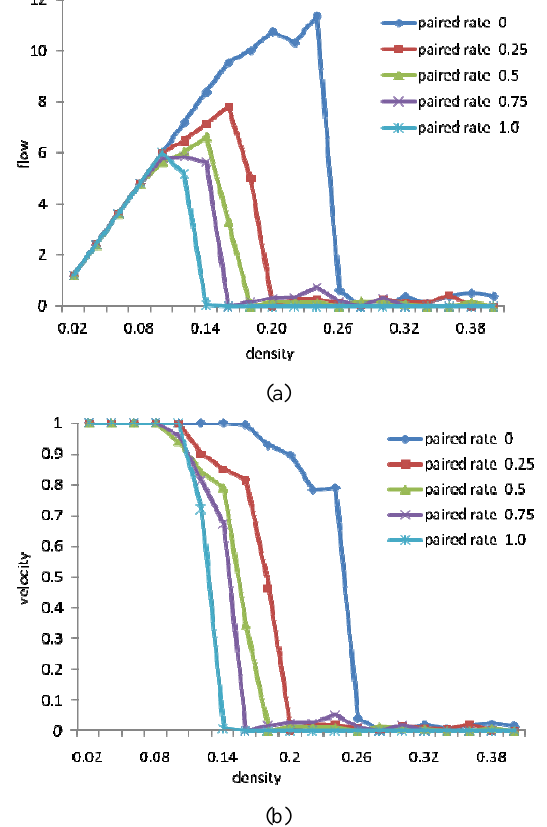
Fig. 4. The flow rate <f> and velocity <v> against the density <d> at various paired